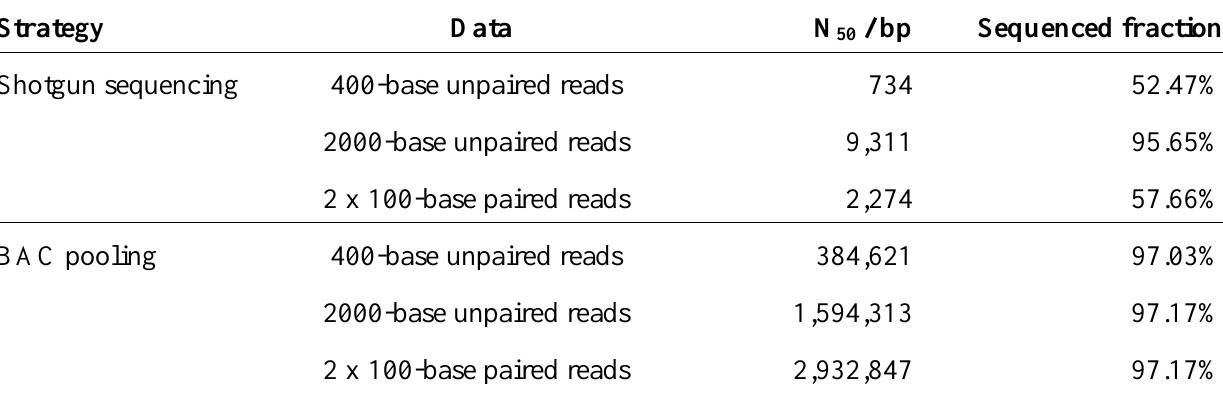
Table 2. Phase determinations as inferred from the simulated assemblies for six alternative and % sequenced fractions identify those strategies sequencing strategies. The greater N 50 with longer contigs and thereby better phase determinations (Figure 4). All simulations were done with two copies of chromosome 2. Heterozygous sites were modeled as single base differences with a rate of 0.1% per site. The unpaired reads were of length 400 or 2000 bases. The reads of the mate pairs were 100 bases long with intervening distances from a normal distribution between 1500 and 2500 bp. All shotgun simulations were performed with 50-times total depth ( i.e. , 25-times coverage for each homolog of this diploid). Each BAC pooling consisted of 243 pools with 100 clones apiece. This pooling resulted in 10-times BAC coverage of the two reference homologs and five-times read coverage of each clone for the same overall depth of 50